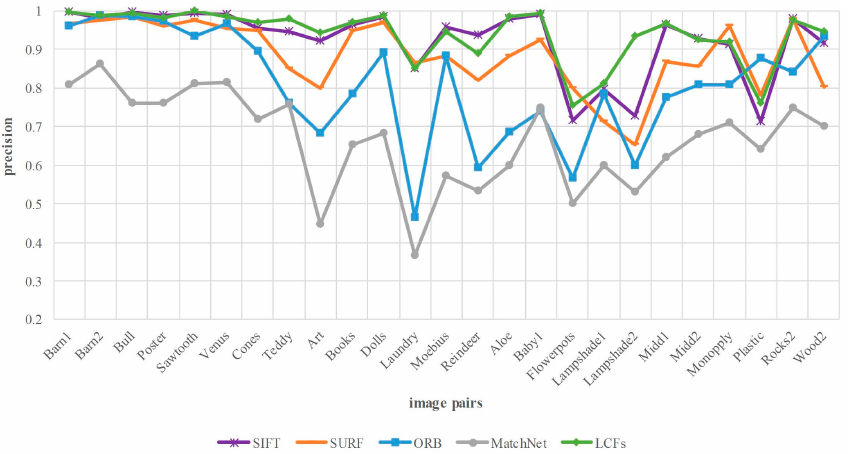
Figure 9. Matching precision comparison between our method and four comparing approaches on Middlebury dataset. The horizontal axis denotes the image pairs, and the vertical axis is the matching precision.